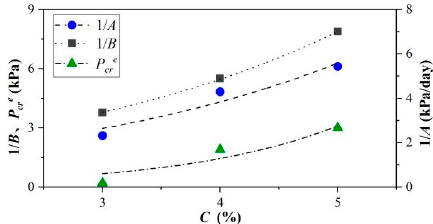
Figure 10. Relationship between cracking pressure P cr and recovery time. The P cr values near the origin of horizontal coordinates represent the elastic recovery, which become significant at high